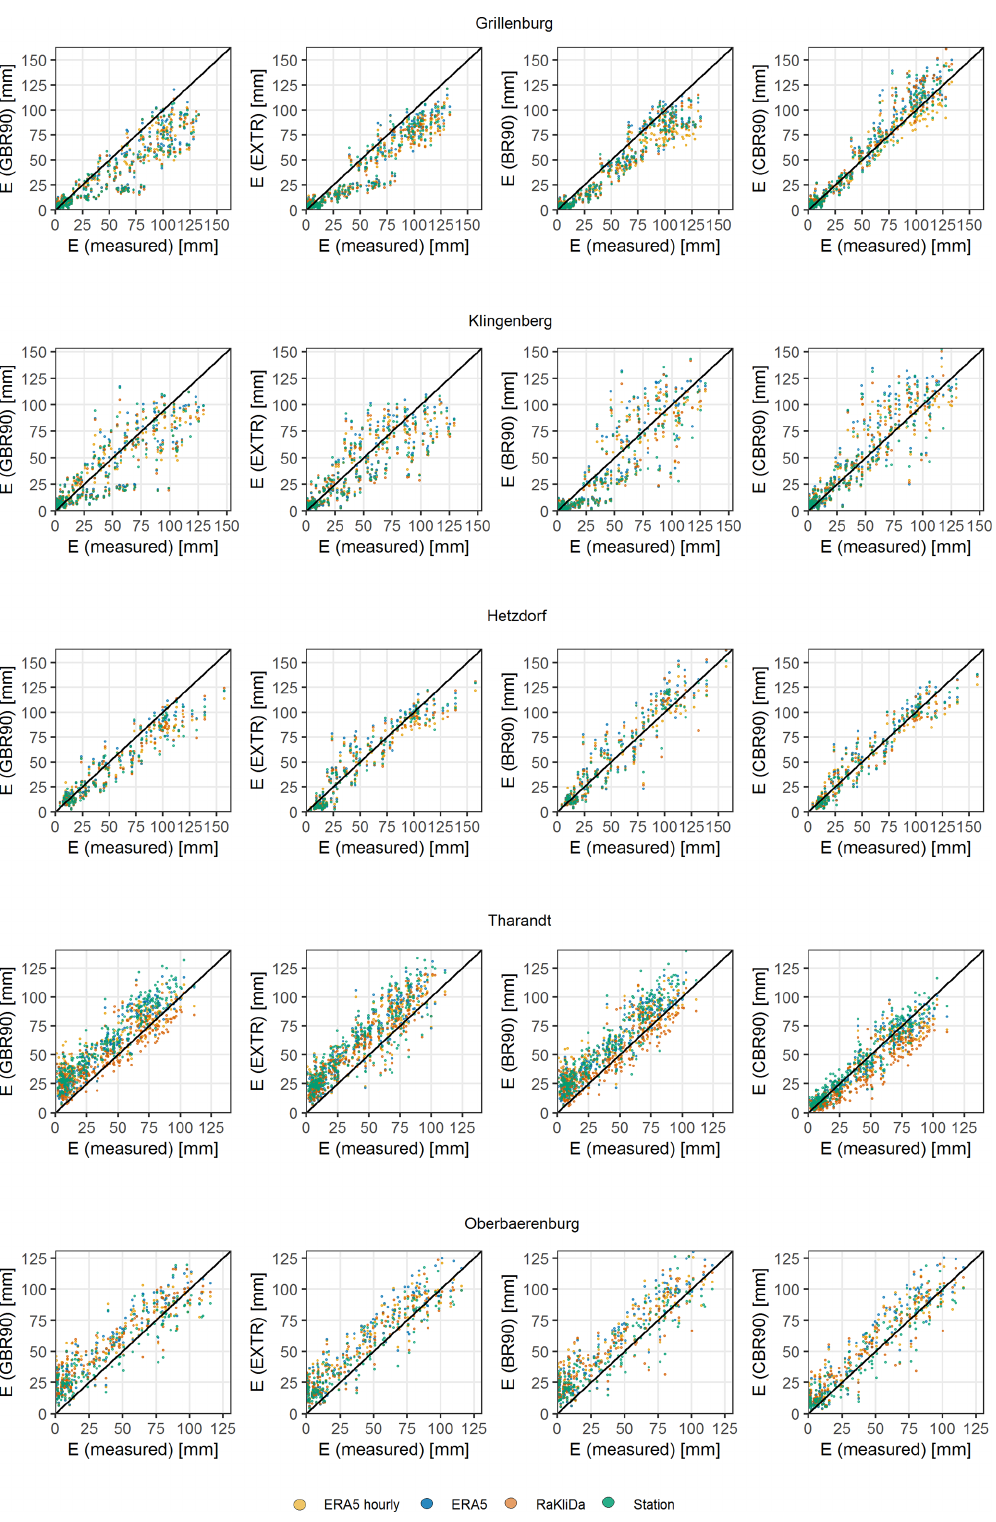
Figure 3. Observed and modelled monthly evaporation values for all